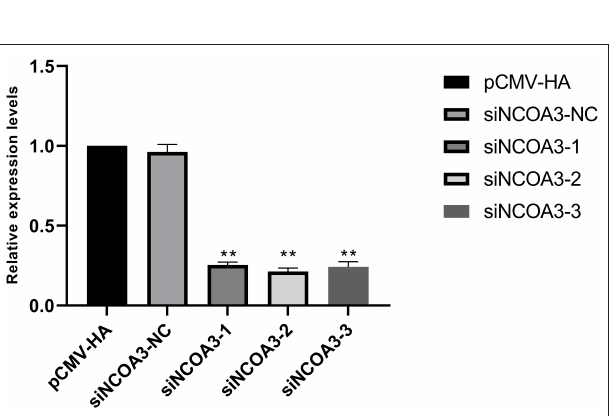
FIGURE 4 | The results of siRNA screening, the lower the expression level of NCOA3 , the better the inhibitory effect. ** p < 0.01.